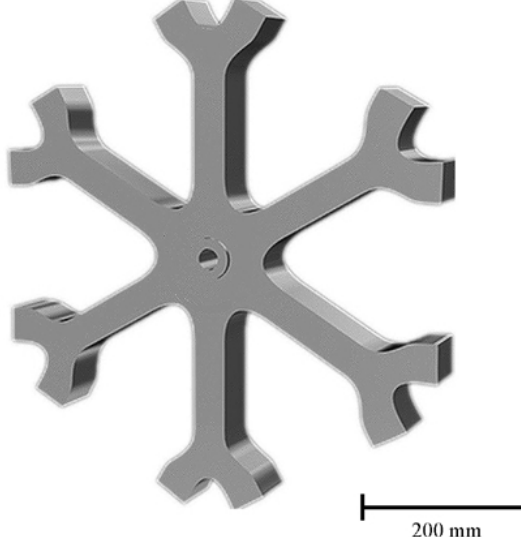
Figure 4. Schematic of a swing